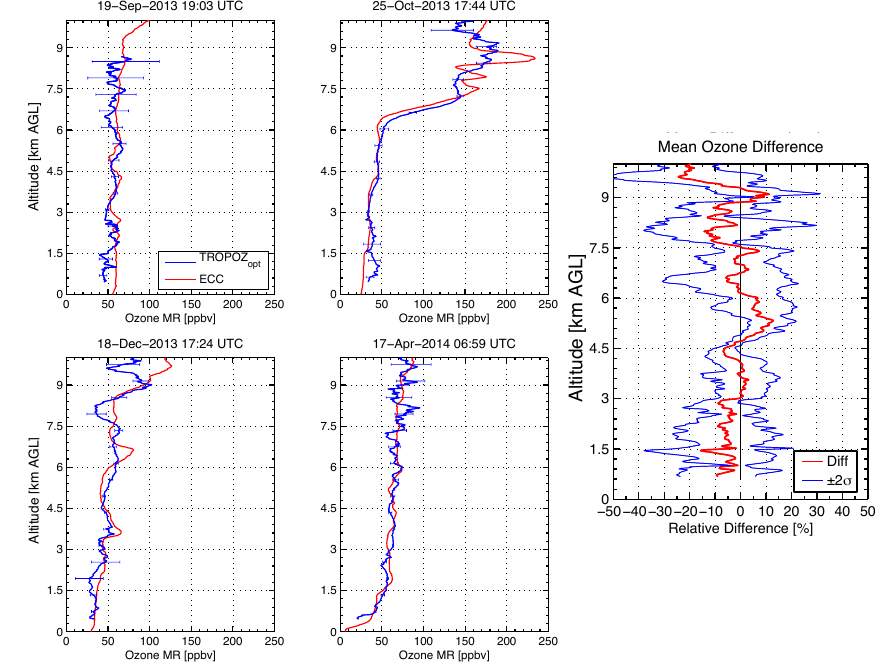
Figure 9. Comparisons between four nearby ECC ozonesonde launches and the updated TROPOZ opt retrieval algorithm.